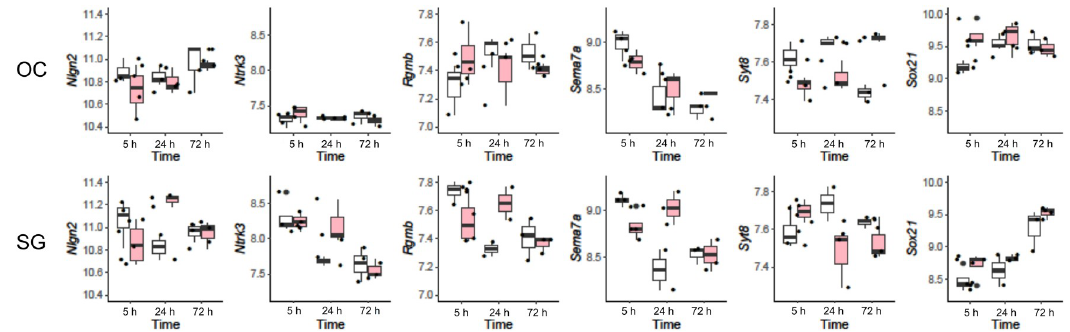
Fig 4. Expression profiles of 6 neuronal regeneration-related genes with significant changes after kainate treatment. Expression levels of 6 transcripts ( Nlgn2 , Ntrk3 , Rgmb , Sema7a , Sox21 , and Syt8 ) in KA-treated (red) and control (clear boxplots) tissue samples of organ of Corti (OC, top row) and spiral ganglion (SG, bottom row) harvested at 5, 24 and 72 hours, are represented by boxplot and superimposed scatterplot.